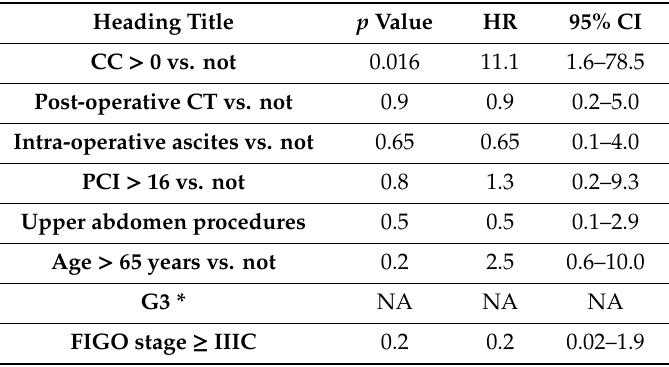
Table 3. Multivariate analysis for OS.